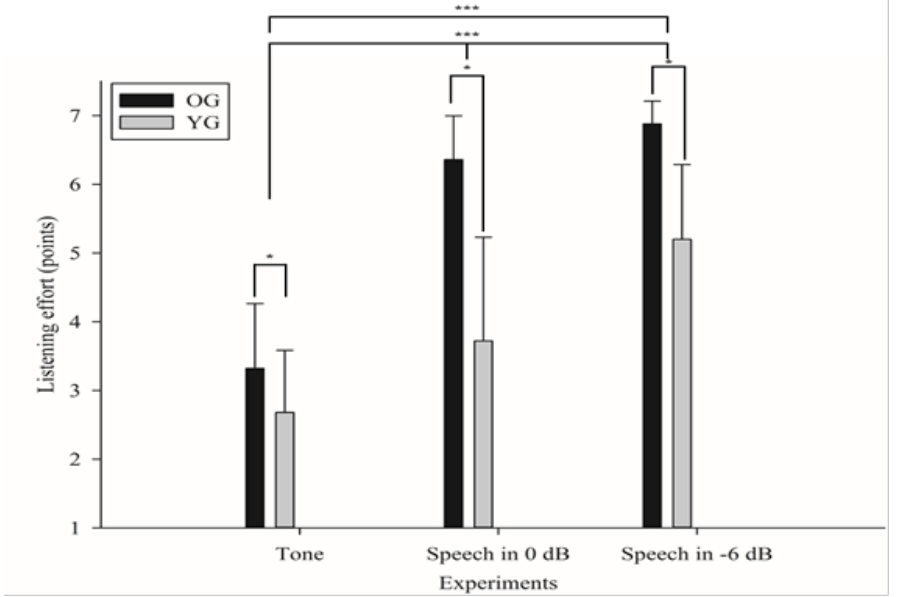
Figure 2. Group comparisons for the amount of listening effort for the conditions. *, p < 0.05; ***, p < 0.001.